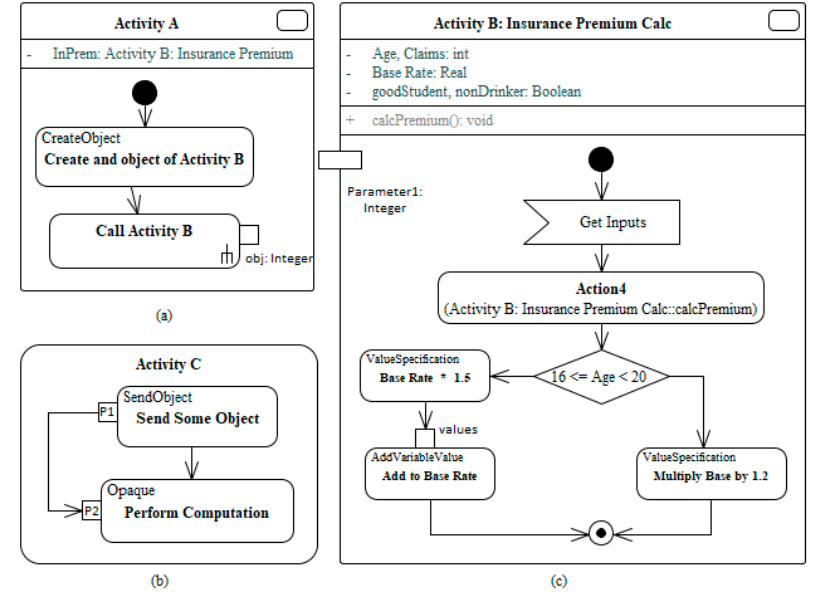
Figure 1. Data flow representation and concepts in activity diagrams (Ads). ( a ) create object and call activity action, ( b ) send object action, ( c ) value specification and guard condition.